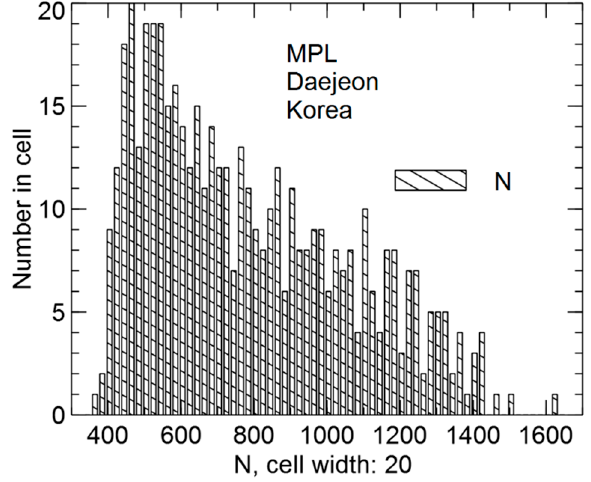
Figure 6. Histogram of the signal estimates N . MPL, Daejeon, Republic of Korea. Here, the average signal estimate N = 784.26 with SNR = 28. The parameter esti- mates were obtained by the calibration method from the experimental data of 494 series of polarization measurements. Figure 7a shows the histograms of the angle deviation es- timates ∆ and ∆ of the transmission axes of the transmitter wave plates, the INC INC Δ and Δ of the receiver wave plates, respectively, and of the PBS transmission SCA SCA axis ξ . Figure 7b shows the histogram of the relative transmission coefficient α